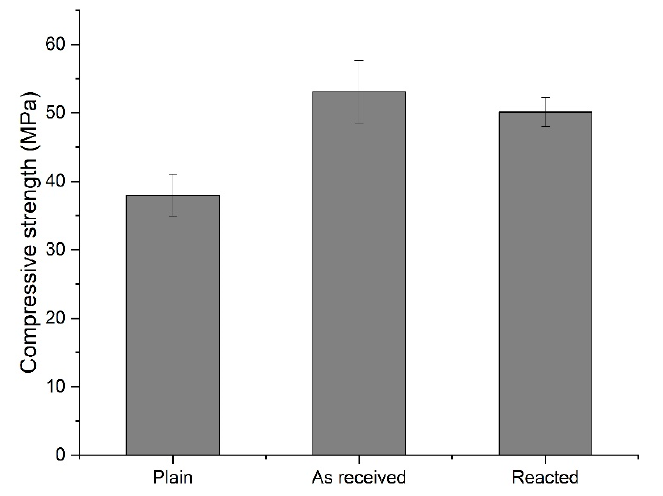
Figure 10. The 28 days compressive strength of mortar using supercritical carbon dioxide-reacted converter slag as fine aggregate .